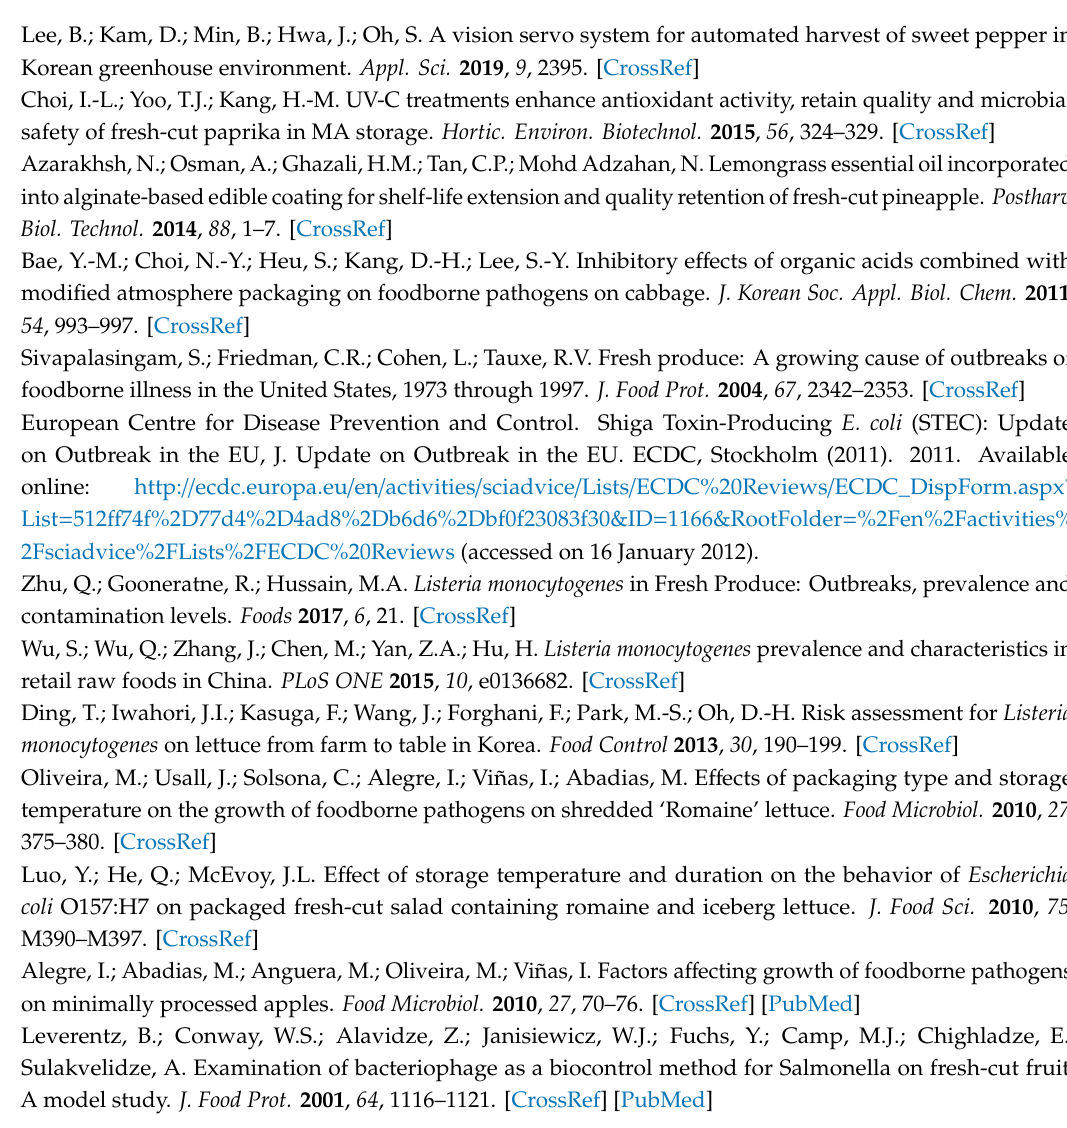
Table S1: Microbial counts, such as total bacterial counts (TBC), total fungal count (TFC), total Salmonella sp. count (TSC), and total Listeria sp. count (TLC), of red fresh-cut bell pepper (R-FCBP) processed with di ff erent treatments and preserved at 4 ◦ C and 15 ◦ C. The results were presented as mean ± SE ( n − 3 ). Table S2: Determination of microbial counts of total bacterial (TBC), total fungi (TFC), total Salmonella sp. (TSC), and total Listeria sp. (TLC) from yellow fresh-cut bell pepper (Y-FCBP) processed with di ff erent treatments and preserved at 4 ◦ C and 15 ◦ C. The results were presented as mean ± SE ( n − 3